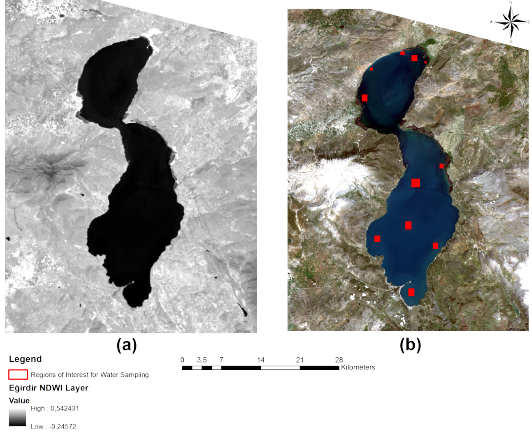
Figure 2. a) NDWI layer calculated with band arithmetic b) Training areas for SVM classification